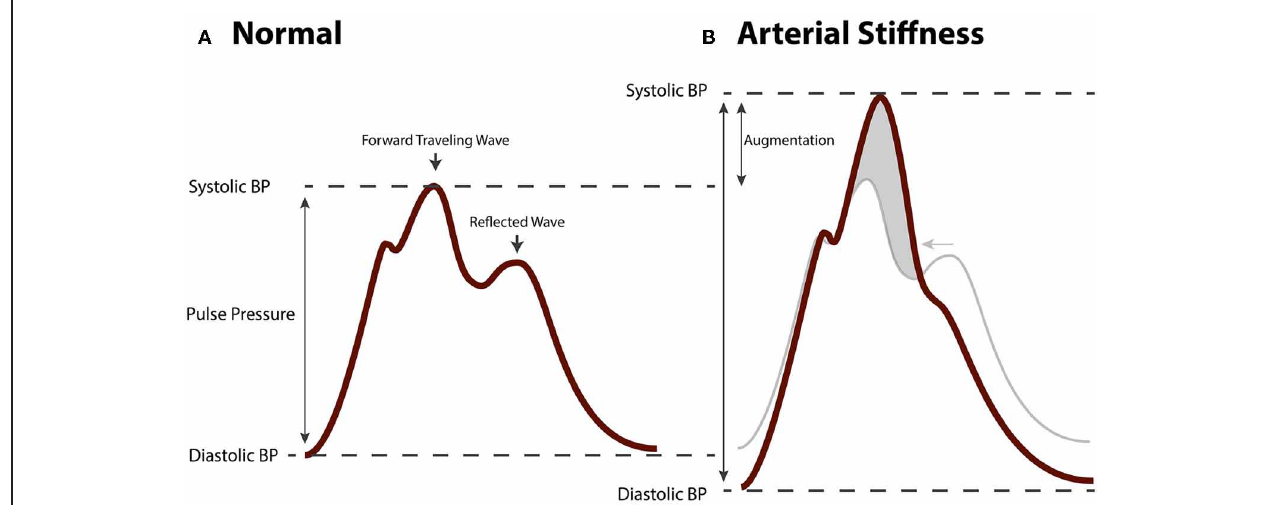
FIGURE 4 | Hemodynamic changes in arterial stiffening. (A) Aortic blood pressure waveform of a healthy, normotensive person. The forwards traveling wave precedes the (backwards traveling) reflected wave. (B) Aortic pressure